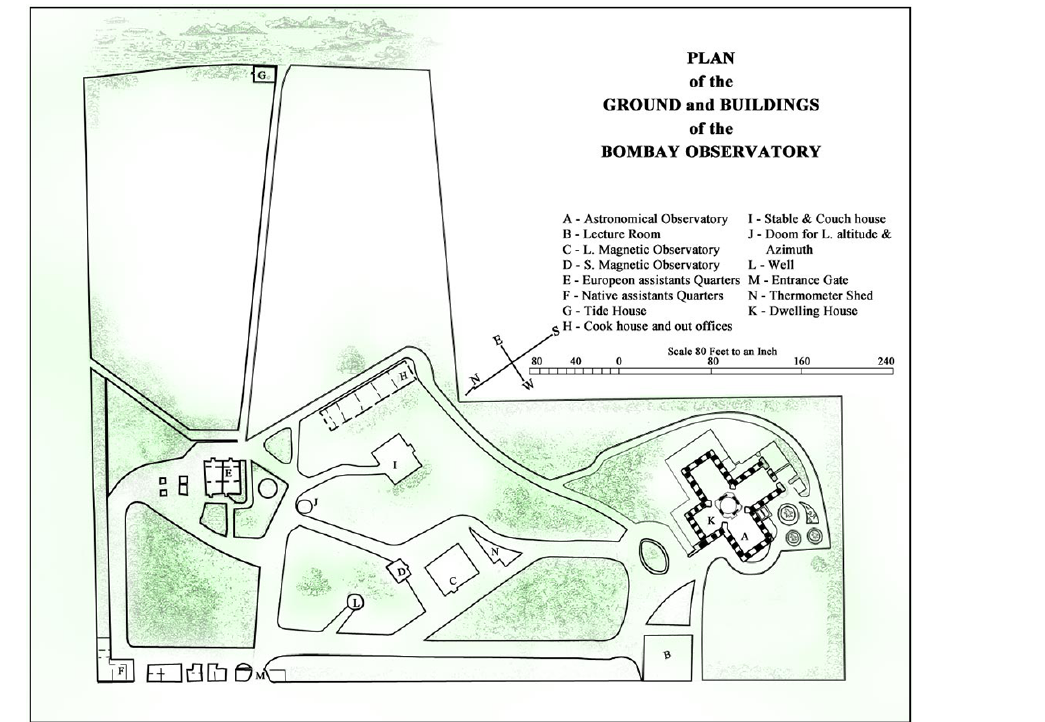
Figure 2. Meteorological observatory and magnetic observatory plan. The meteorological observatory established in 1826 by the East India Company made some room for magnetic instruments in 1841. Once installed, these magnetic instruments carved a niche for themselves and immortalized the place as the Colaba magnetic observatory (Orlebar,